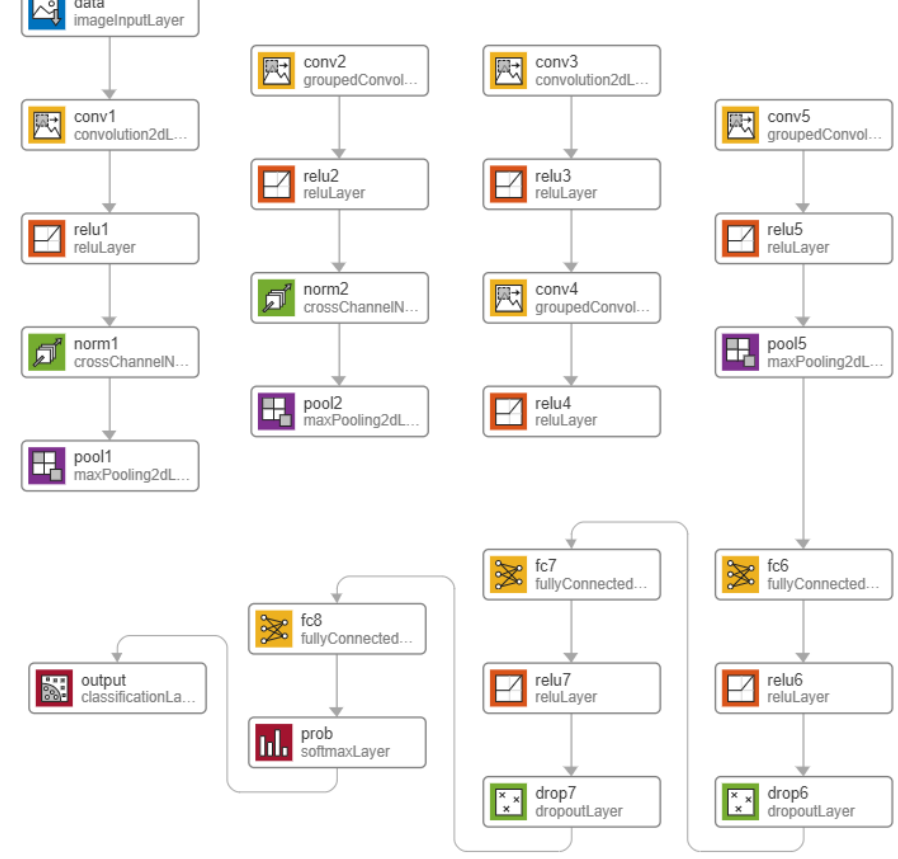
Figure 6. AlexNet Network Layer Structure: This is a 25-layer series architecture imported via Matlab Deep Network Designer. The CNN model accepts 227 × 227 image inputs and is trained to classify between 1000 image classes via ImageNet.